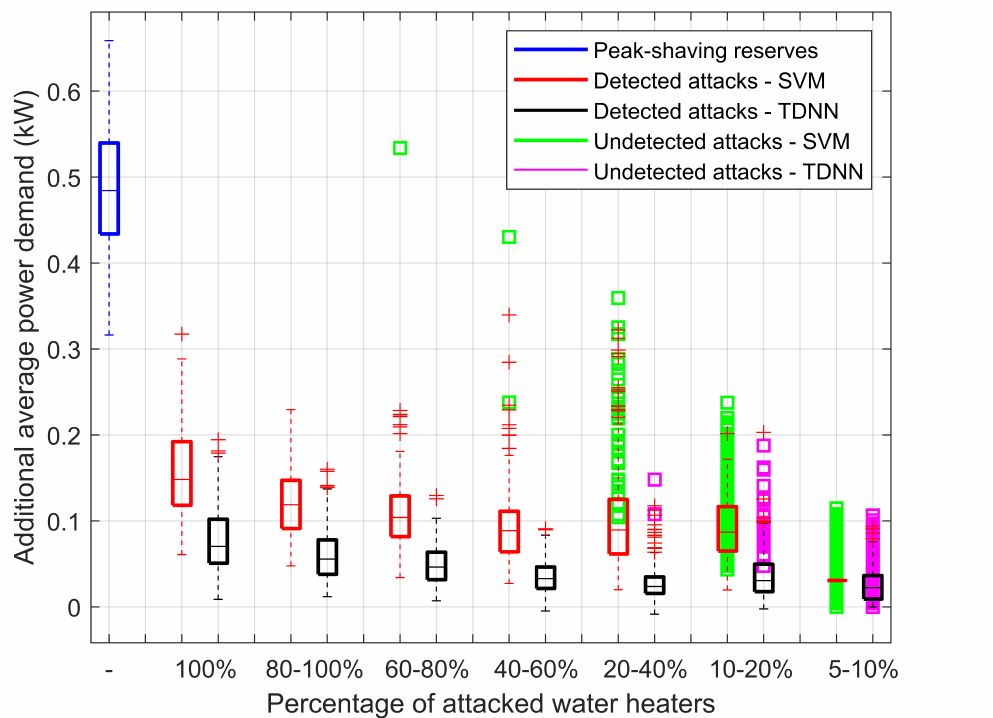
Figure 6. Excess power demand generated by DLC attacks activating a subset of EWHs with the mitigation delay of 15 min—winter